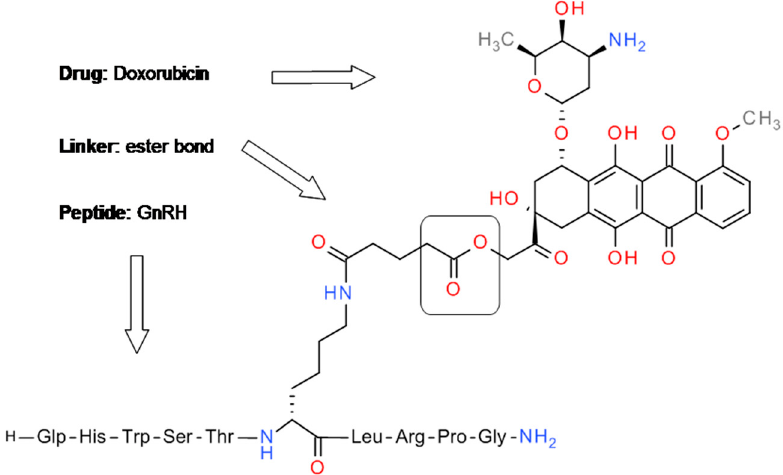
Figure 2. Chemicalstructureofgonadotropin-releasinghormone(GnRH)orluteinizinghormone-releasing Figure 2. Chemical structure of gonadotropin-releasing hormone (GnRH) or luteinizing hormone (LHRH)-doxorubicin conjugate (Zoptarelin Doxorubicin, AN-152, hormone-releasing hormone (LHRH)-doxorubicin conjugate (Zoptarelin Doxorubicin, AN-152, AEZS-108).